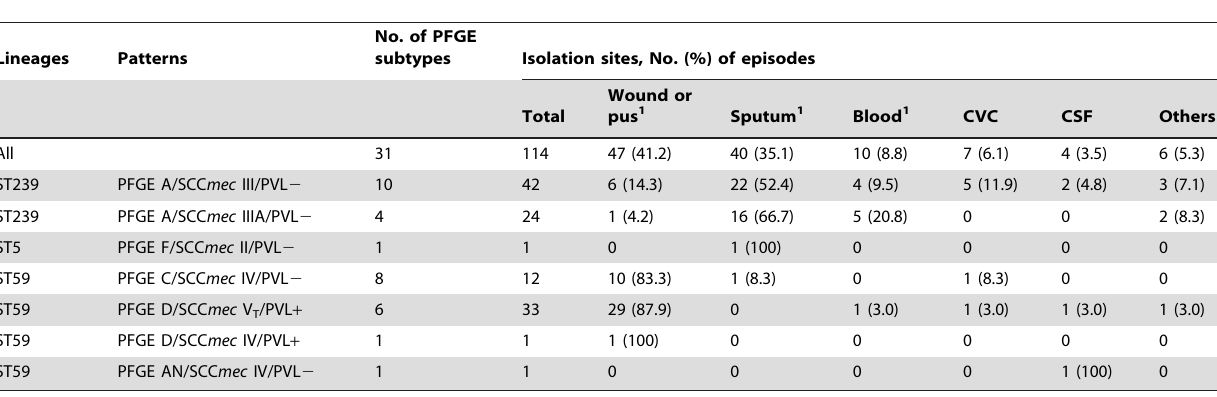
Table 3. Distribution of isolation sites for 7 clones of MRSA responsible for 114 episodes of repeated infections in 48 children.